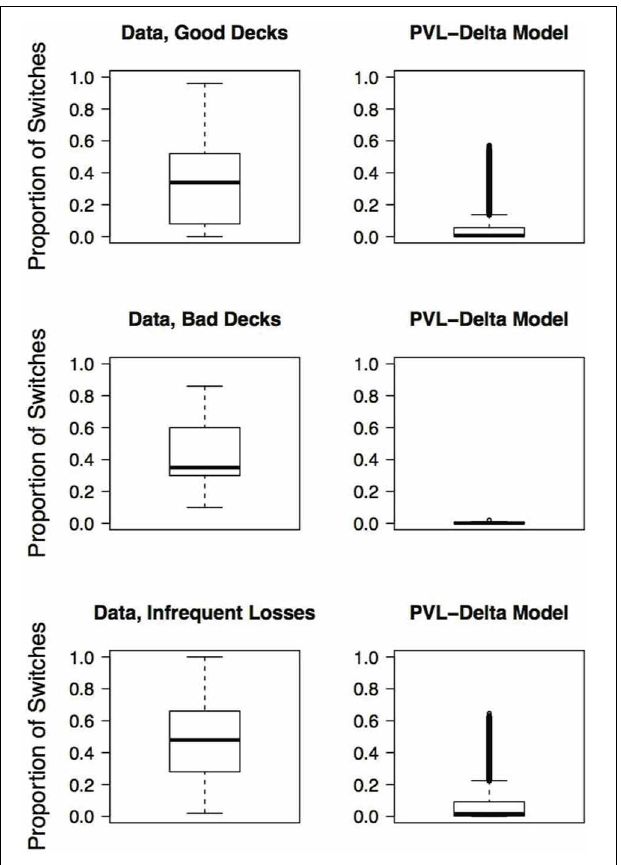
FIGURE 1 | Boxplots of observed and generated proportions of switches during the last 50 trials, given a pronounced deck preference. Each row presents the results for different pronounced choice patterns: First row: Pronounced preference for the good decks; Second row: Pronounced preference for the bad decks; Third row: Pronounced preference for the decks with infrequent losses. The first column presents the switches of 211 healthy participants selected from the Steingroever et al. (2013a) data pool (cf. Table 2 ). The second column presents the switches generated by the PVL-Delta model (cf. Table 4